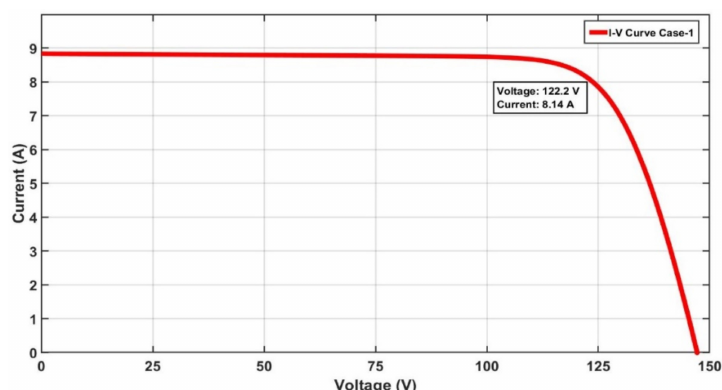
Figure 19. P-V curve (Case-1).